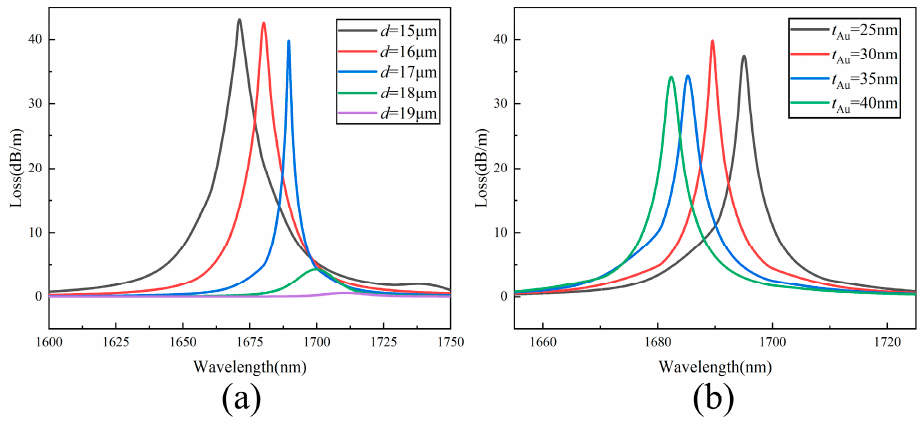
Figure 4. ( a ) Confinement losses for different air hole sizes d ; ( b ) confinement loss for different thicknesses of the gold film.